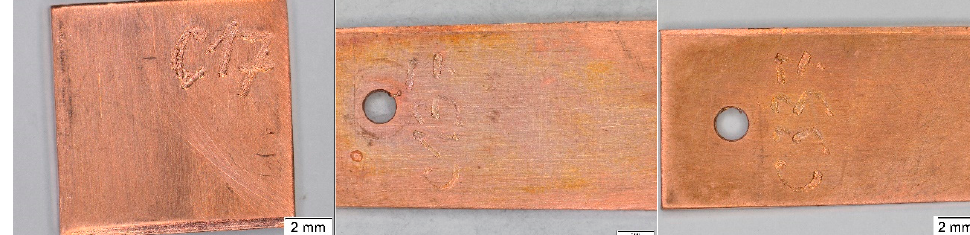
Figure 5. Comparison of the appearance of the copper coupons with the highest value of the total color difference (a library from location 1 on the ( left ), a church from location 15 on the ( right )).